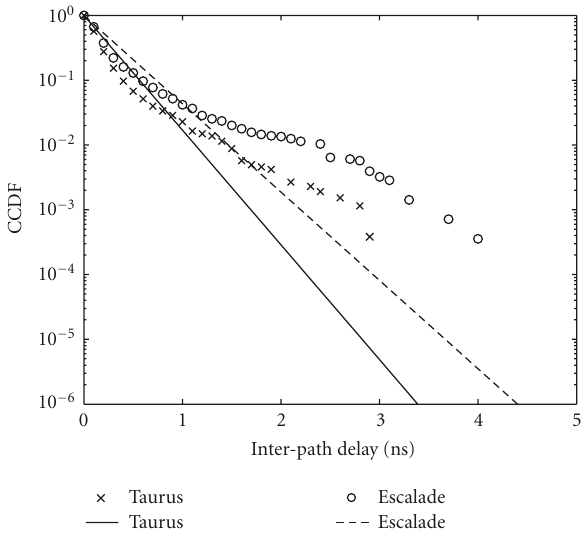
Figure 12: CCDF of interpath arrival intervals and the best- fit exponential distributions for measurements inside the engine compartments.